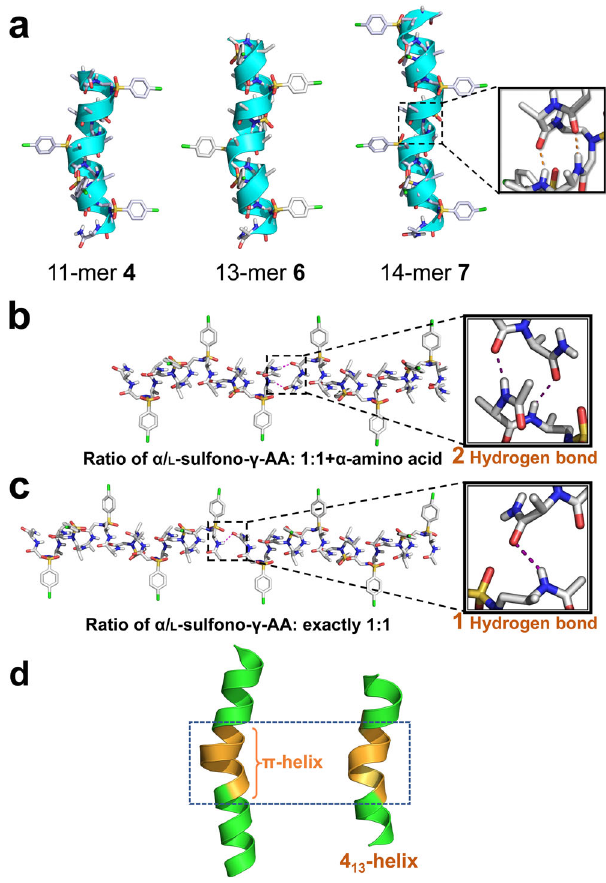
Fig. 2 Single crystal structures of oligomers 4, 6, and 7. a Single-crystal structures of 4 13 -helix formed by 11-mer 4 , 13-mer 6 , and 14-mer 7 . The intramolecular hydrogen bond was indicated as orange dashed line in the inset. The nonpolar hydrogens were omitted for clarity. Solvent molecules were also excluded from the crystal lattice. b Two sets of head-to-tail intermolecular hydrogen bonding in the 1:1 + α type of oligomers; c One set of head-to-tail intermolecular hydrogen bonding in the exactly 1:1 ratio type of oligomers. d A comparison of π -helix and 4 13 -helix. Left: a short seven residue π -helix (orange) embedded within a longer α -helix (green), taken from PDB code 3QHB. Right: a short seven residue fragment of π -helix mimetic (orange), taken from 11-mer 4